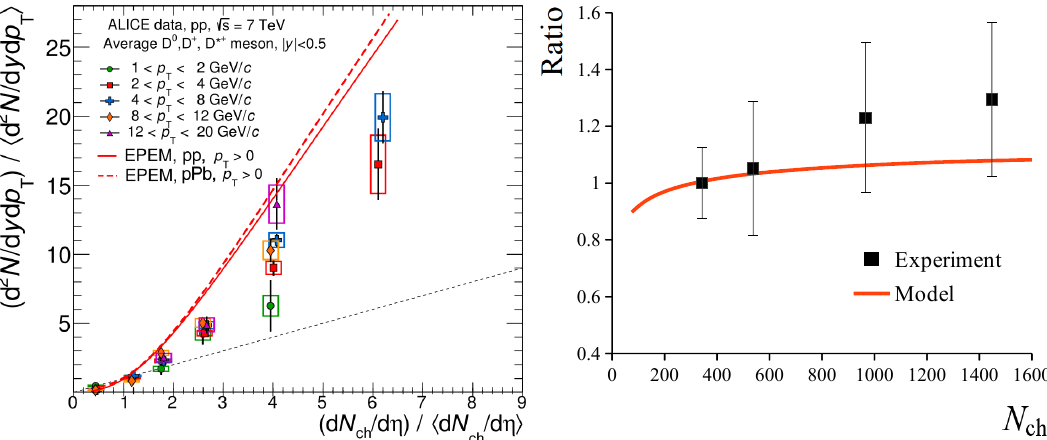
√ s = 7 TeV as a function